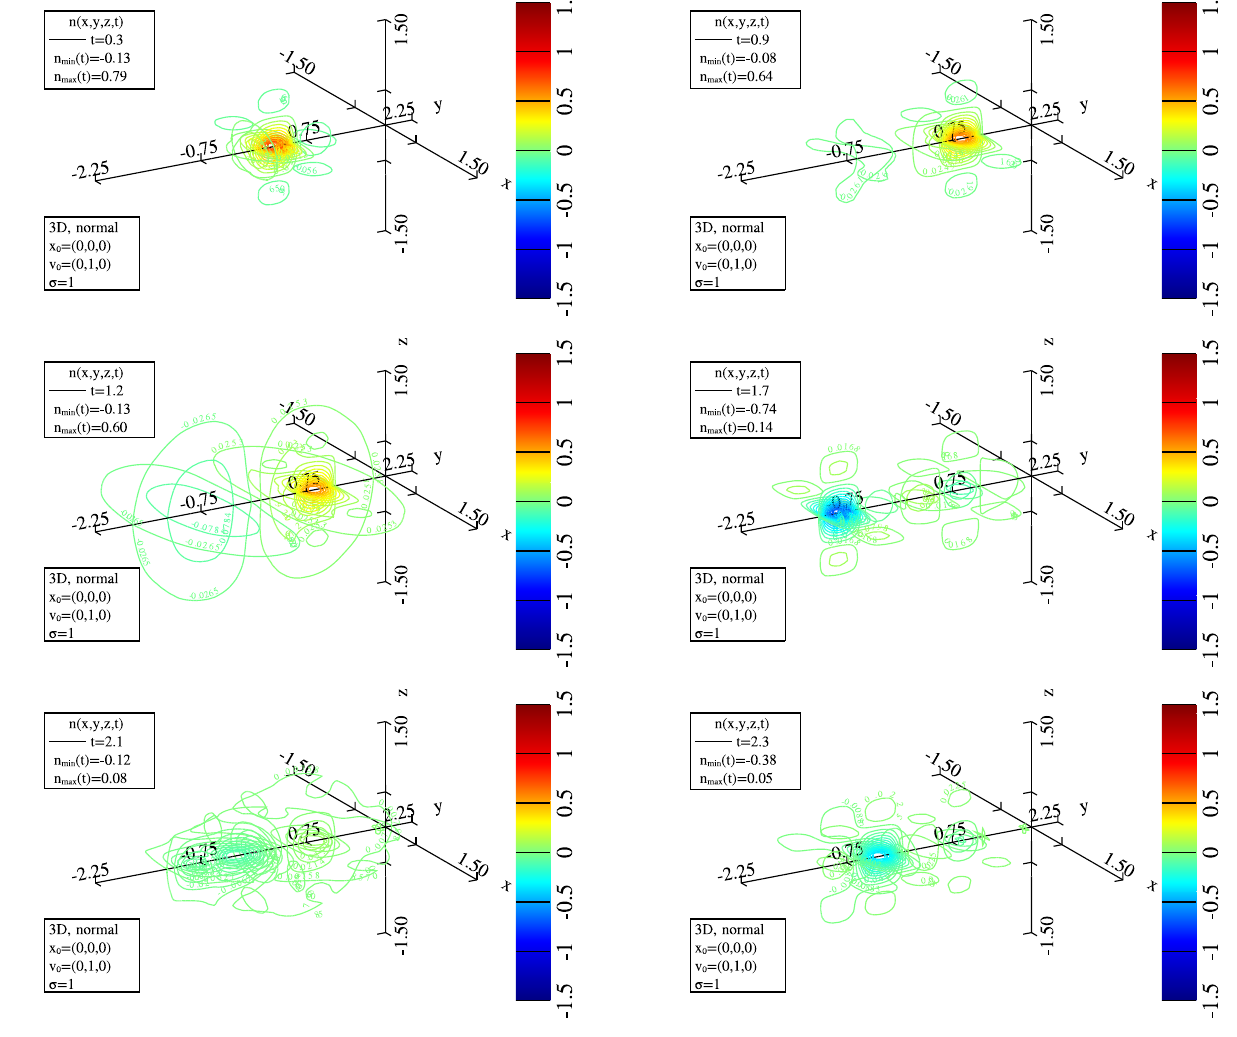
FIG. 8. Dynamics of the density n ð ~ x ; t Þ for the 3D plasma with normal spatial and velocity distributions for different values of time; the external charge starts moving from ~ x 0 ¼ ð 0 . 0 ; 0 . 0 ; 0 . 0 Þ with velocity ~ v 0 ¼ ð 0 . 0 ; 1 . 0 ; 0 . 0 Þ